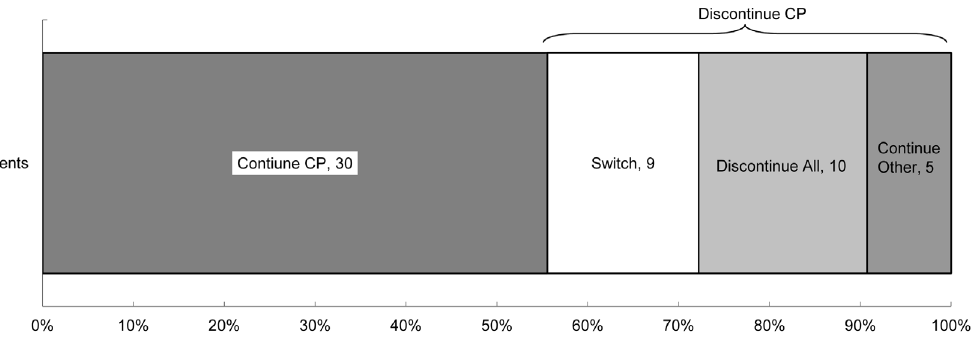
Figure 2. Prescription changes among cabergoline/pergolide user in one year before and after the 2007 measures. Continue CP: Continued cabergoline or pergolide until the end of the study period. Switch: Switched to other anti-Parkinson drugs. Discontinue All: Discontinued all anti-Parkinson drugs at once. Continue Other: Continued other anti-Parkinson drugs that had been co-prescribed. Nine patients switched from cabergoline or pergolide to other anti-Parkinson drugs (seven to pramipexole, one to ropinirole, and one to talipexole) during the period before April 2007 (three) and after April 2007 (six). Twenty-three patients were prescribed cabergoline or pergolide before April 2007 and continued after the 2007 revision: 18 were in the Continue CP group, four were in the Switch group, and one was in the Discontinue All